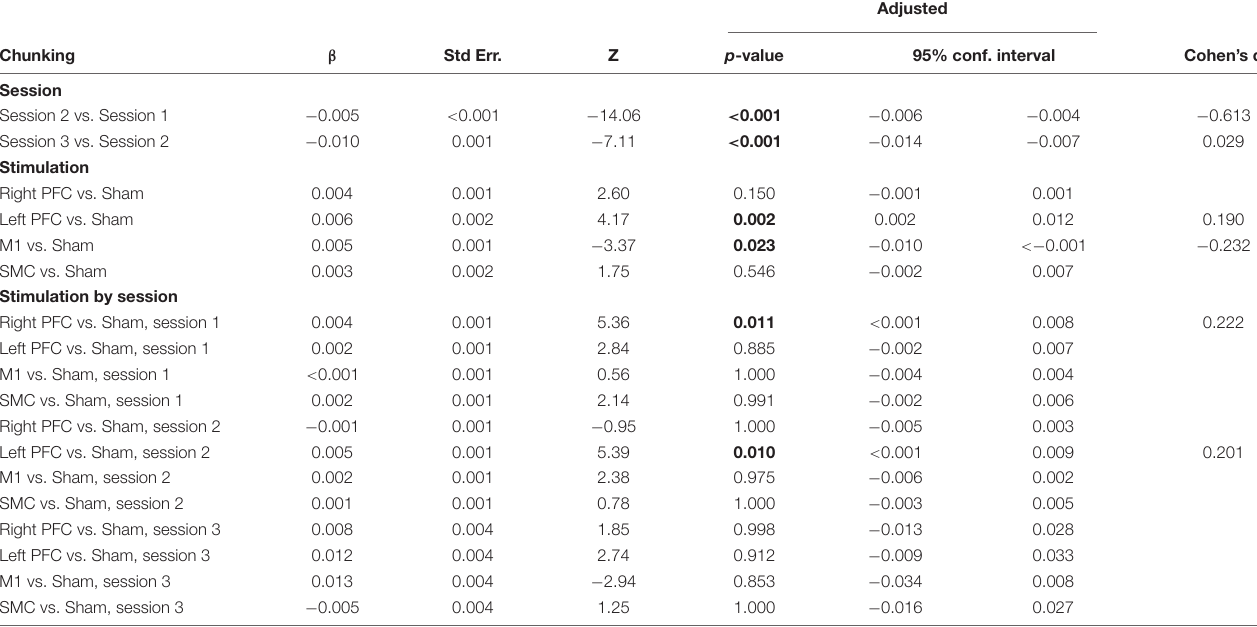
TABLE 5 | Results from linear mixed model using number of chunks as the dependent variable for older adults.